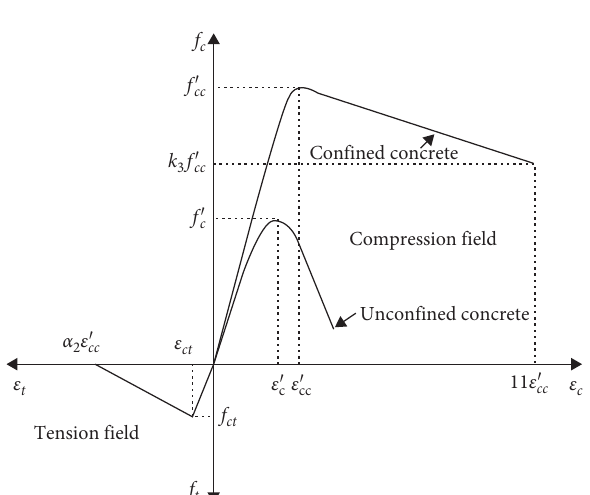
Figure 5: Stress-strain curve of concrete in uniaxial stress